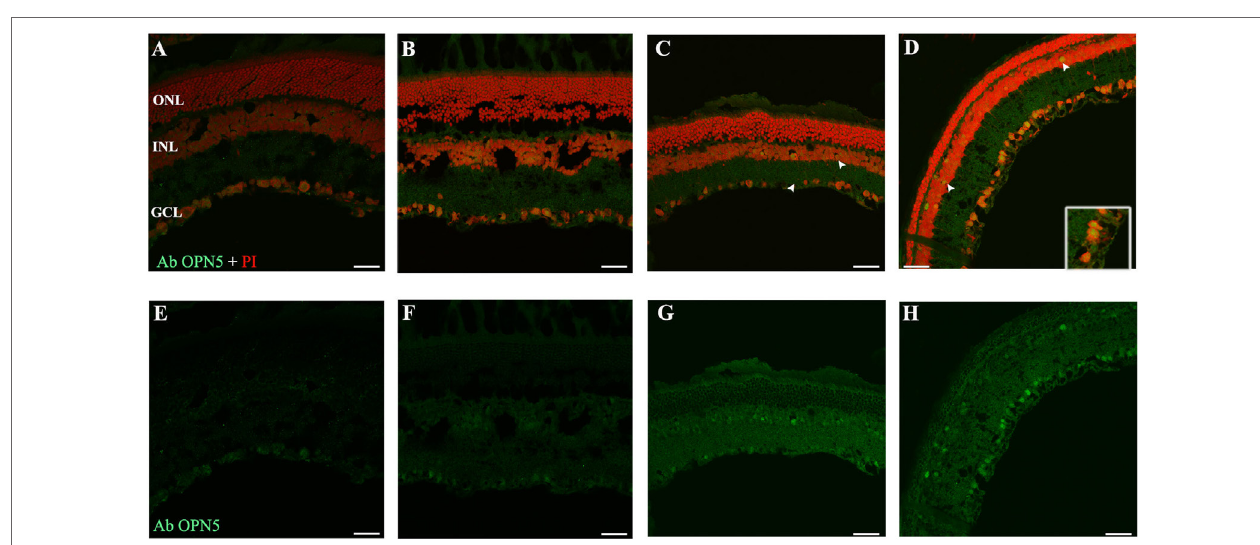
FigUre 6 | Analysis of OPN5 protein expression in retina of animals exposed to light: (a,e) retinas maintained in dark during 4 days showing low positive staining in retinal ganglion cell (RGC). (B,F) Retinas maintained in LD 8 days showing a similar pattern as in DD. (c–h) Light-treated animals during 2 and 8 days in LL showing labeling in RGC and INL. The images are representative of three different experiments per treatment. Green: OPN4 antibody staining; blue: nuclear PI staining. Scale bar indicates 30 µm.